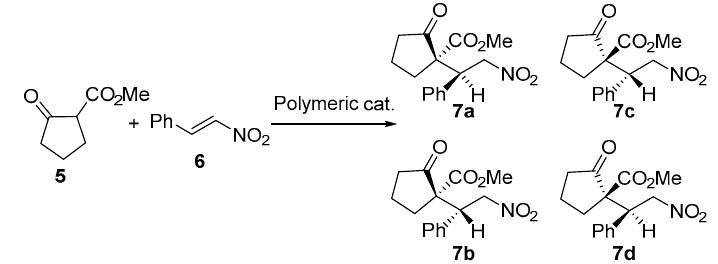
Figure 2. Hoveyda-Grubbs 2nd generation catalysts ( HG 2